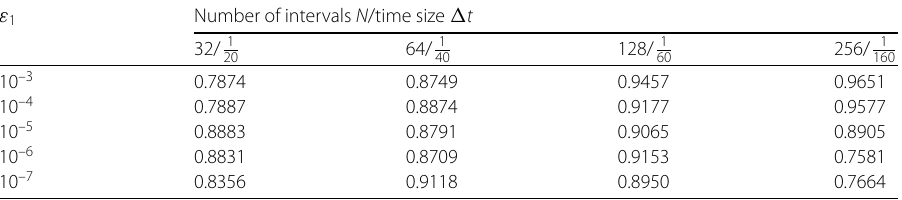
Table 4 Rate of convergence r N , M ε for Example 5.1 using the adaptive grid method with ε 2 = 10 1 , ε 2